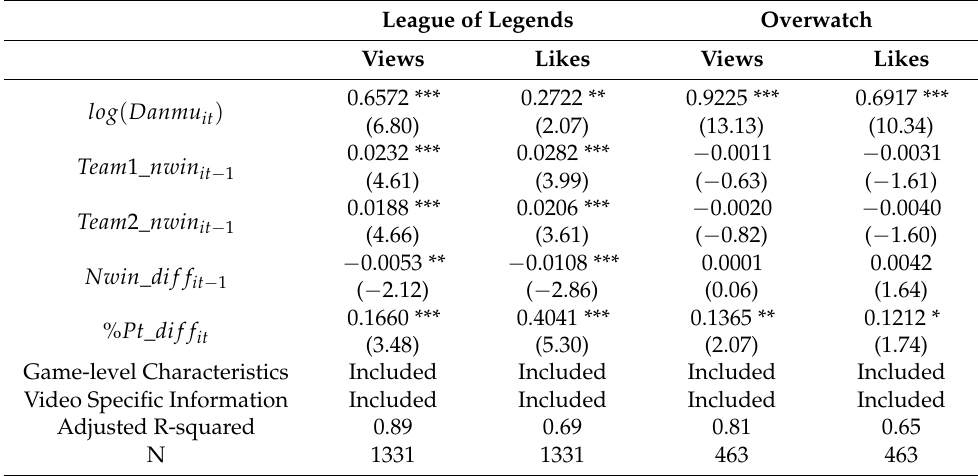
Table 4. Estimated Effects on Full Esports Match Viewer